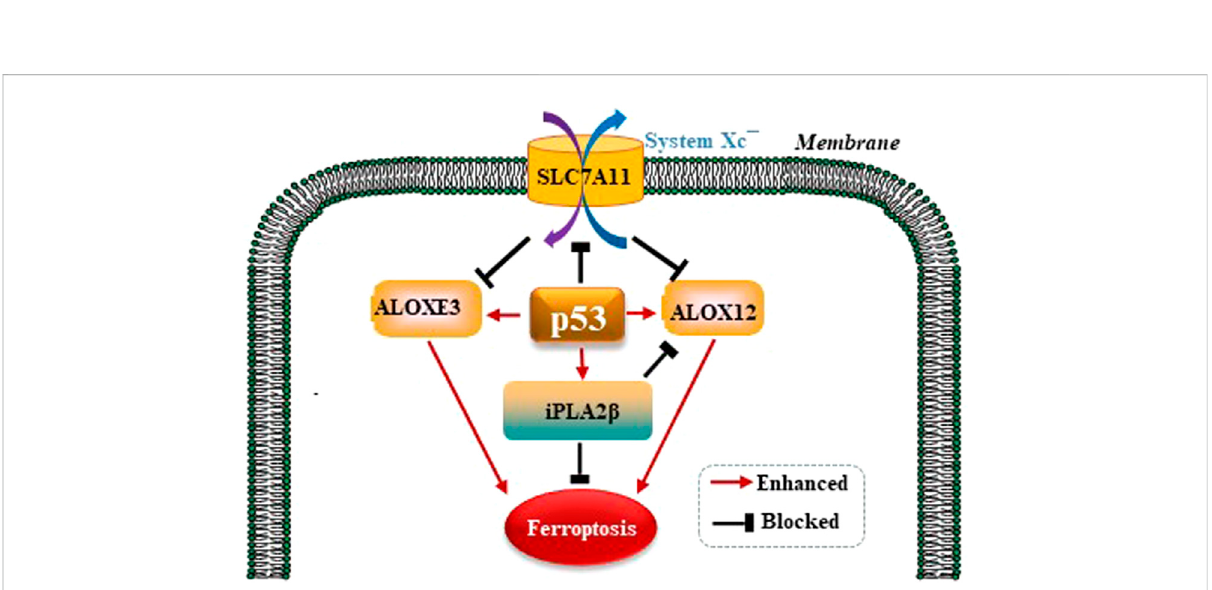
FIGURE 4 p53 modulates GPX4-independent ferroptosis pathways. p53/ SLC7A11/ALOX12 and p53/SLC7A11/ALOXE3 axes can both collaboratively